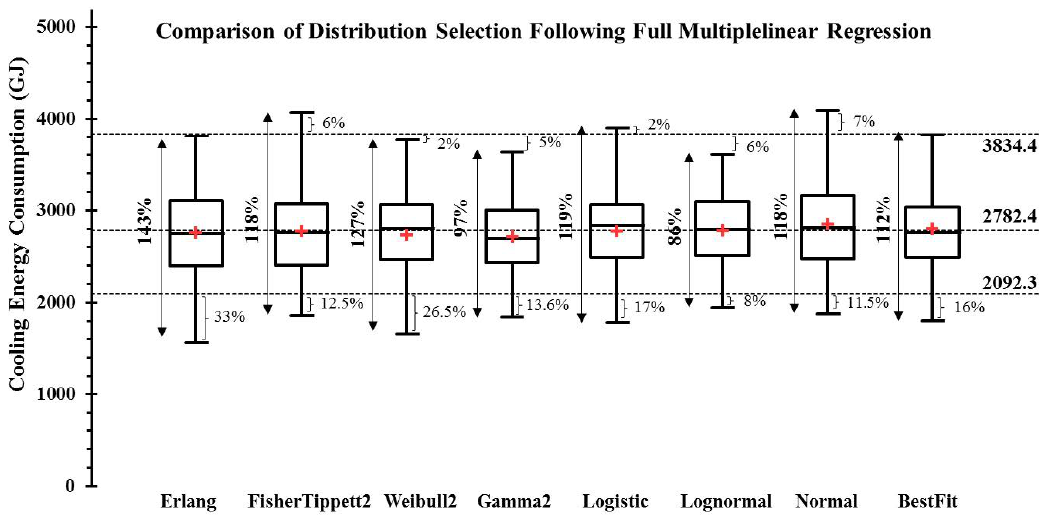
Figure 11. Cooling energy use probability density functions when following a full multiple linear regression model and comparing selection of various input average annual weather variables distributions used in the uncertainty propagation method.